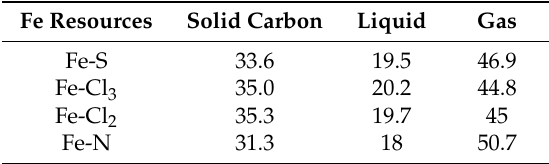
Table 1. Effects of iron sources on products weight percentage distribution of catalytic decomposition of kraft lignin at the temperature of 1000 ◦ C for 1 h.